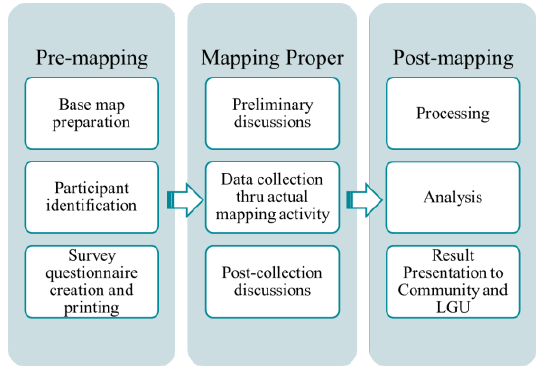
Figure 2. Participatory mapping workflow in the study. The workflow is divided into three stages: pre-mapping, mapping proper and post-mapping.